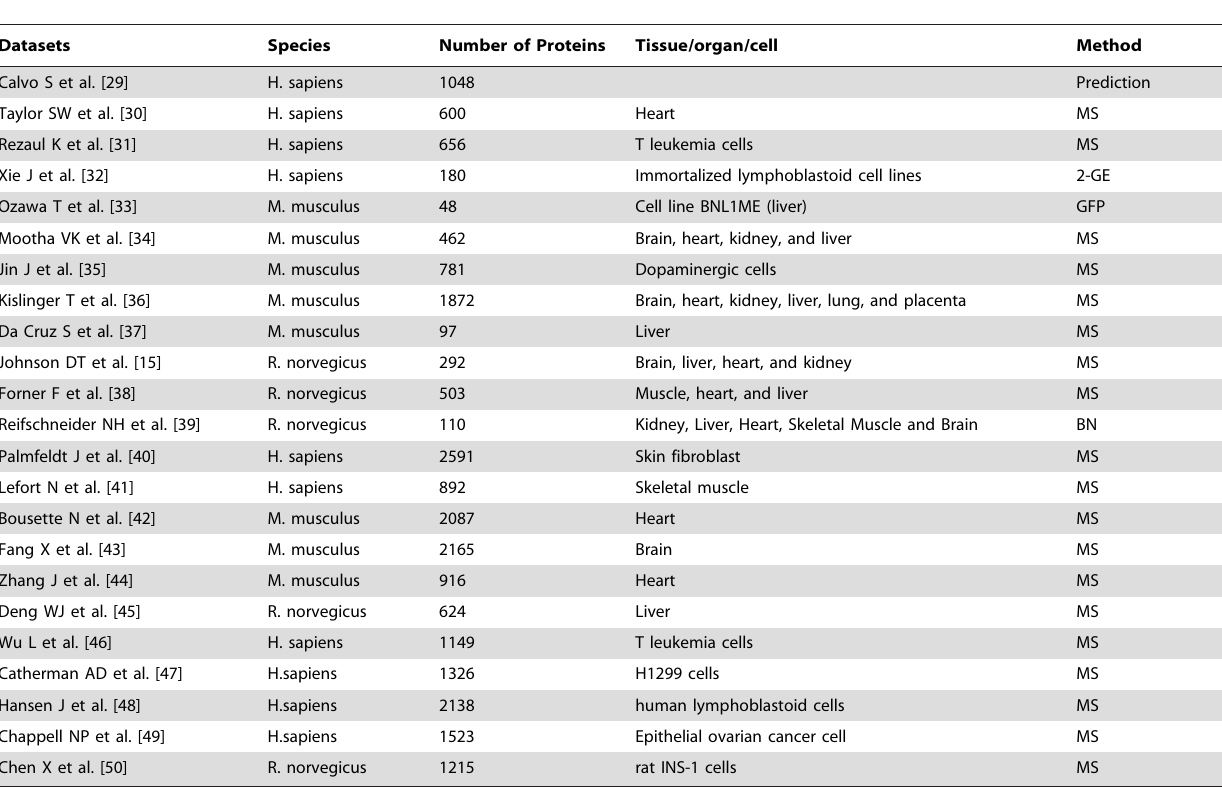
Table 1. Integrated mitochondrial proteomic datasets for an inventory of mammalian mitochondrial